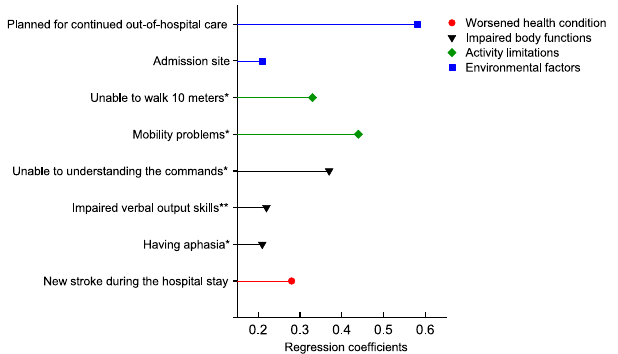
Figure 2. The regression coefficients of the 10-fold cross-validated adaptive least absolute shrinkage and selection operator model. *Indicates post-stroke conditions.